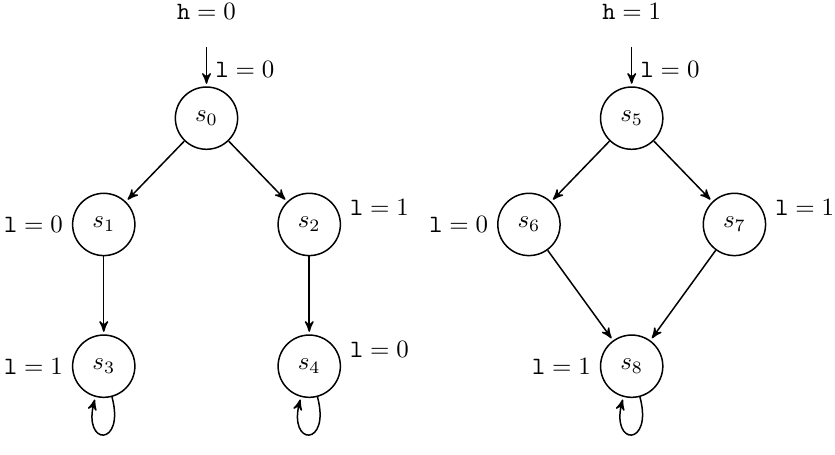
Figure 1. Kripke structure of the program P1